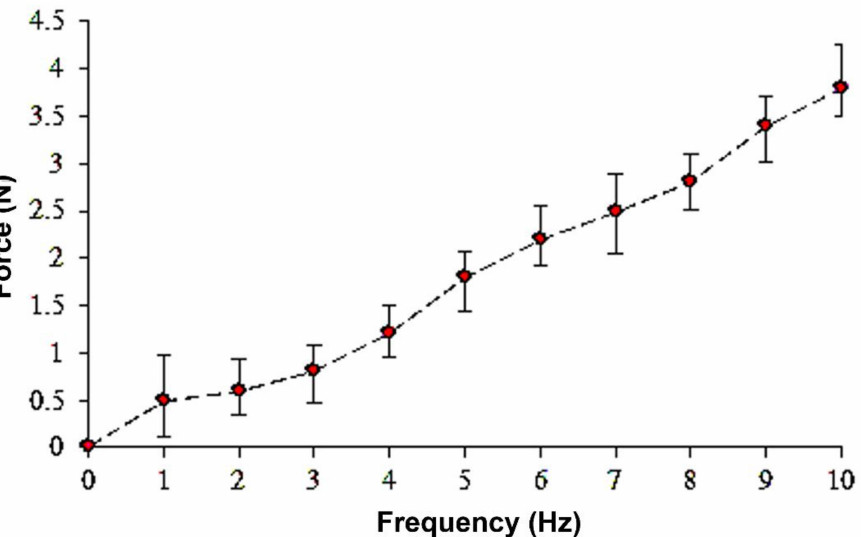
Figure 8. Force analysis of PVDF piezoelectric fiber energy acquisition device when applying a tapping frequency of 1–10